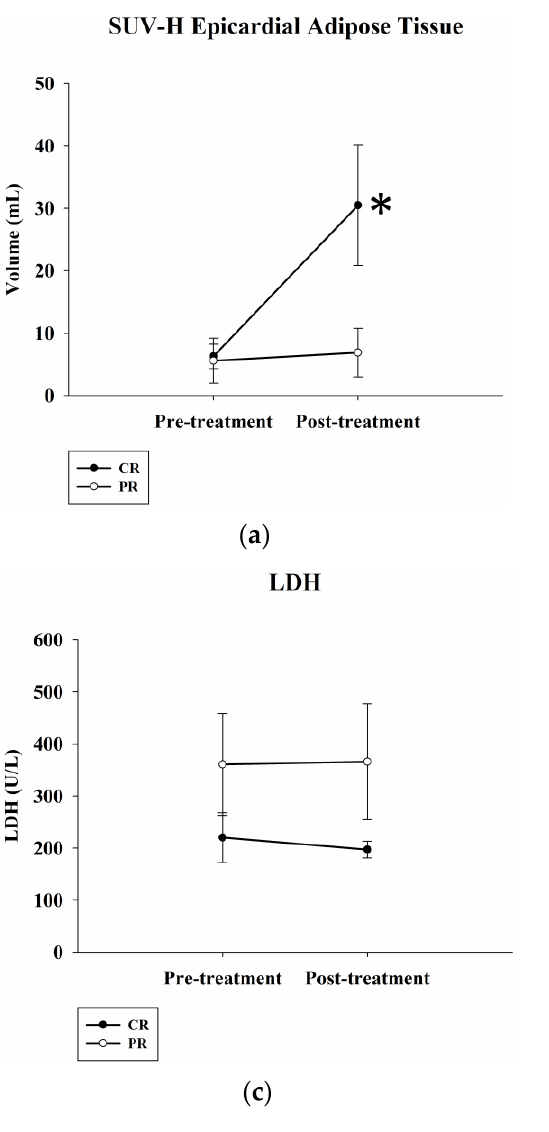
Figure 3. Pre- and post-treatment SUV-H EAT, SUV-H OAT volumes, serum LDH levels, and BMI in complete and partial responders. ( a , b ) The SUV-H EAT and OAT volume significantly increased in complete responders ( p = 0.04 and 0.002, respectively). There were no significant differences in pre- and post-treatment SUV-H EAT and OAT volumes in partial responders ( p = 0.27 and 0.19, respectively). ( c , d ) No significant differences were found in pre- and post-treatment serum LDH levels and BMI in complete and partial responders. * Differences are significant at the 0.05 level (two-tailed). ** Differences are significant at the 0.01 level (two-tailed). SUV-H EAT, high standardized uptake value epicardial adipose tissue; SUV-H OAT, high standardized uptake value orbital adipose tissue; LDH, lactate dehydrogenase; BMI, body mass index; CR, complete response; PR, partial response.